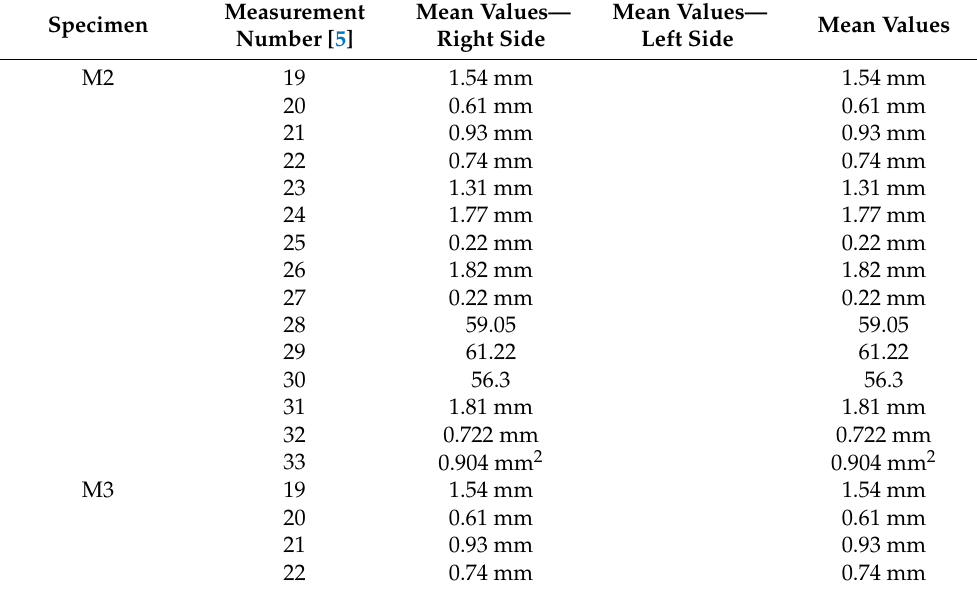
Figure 5. Anatomical features of the stapes. (1) articular surface for incus; (2) head of the stapes ( Caput stapedis ); (3) anterior crus ( Crus rostrale ); (4) tendon of the stapedial muscle; (5) stapedial muscle tubercle; (6) posterior crus ( Crus caudale ); (7) stapedial footplate ( Basis stapedis ); (8) intercrusal foramen; yellow arrow—the bony spicule, a remnant of the stapedial artery. Table 5. Metric dimensions of the stapes in green monkey